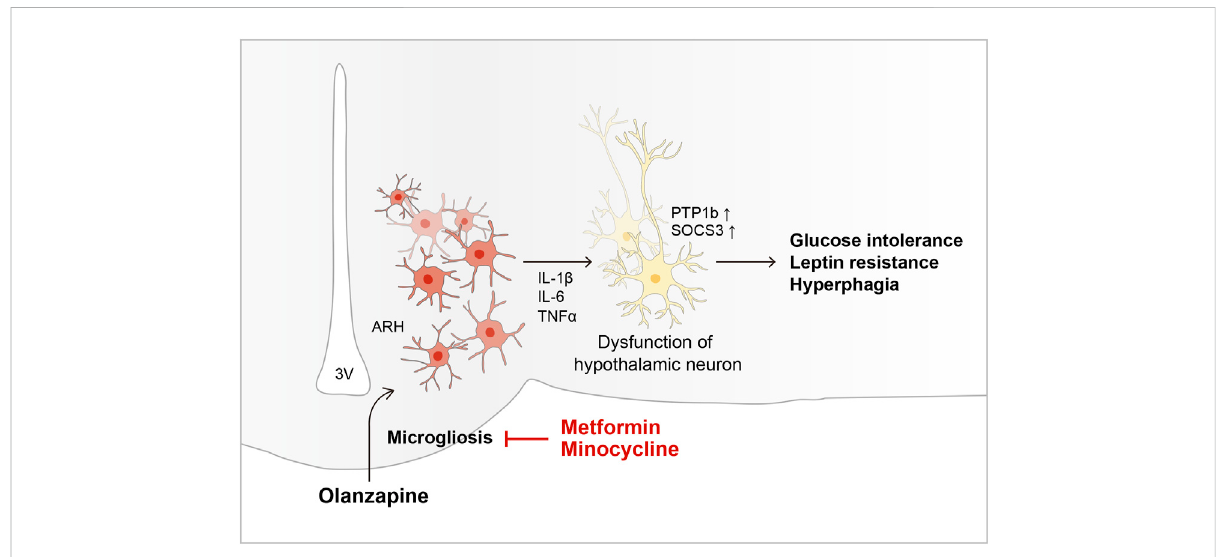
FIGURE 6 Schematic diagram of the mechanism underlying OLZ-induced hypothalamic microgliosis and metabolic